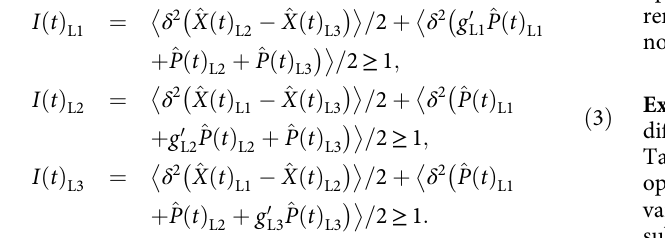
Values for atomic spin Values for released submodes (dB) waves (dB)